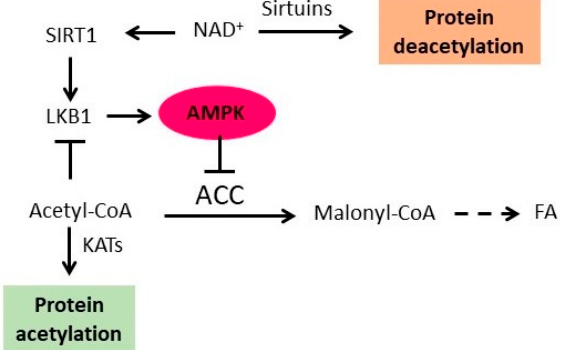
Figure 2. Model of the feedback regulation of AMPK by protein acetylation. AMPK phosphorylates and inhibits ACC, thus increasing acetyl-CoA cellular level and promoting KAT-mediated protein acetylation. Acetylation of liver kinase B1 (LKB1) inhibits the ability of LKB1 to activate AMPK. AMPK also promotes synthesis of NAD + , thus activating SIRT1 and other sirtuins and promoting protein deacetylation. SIRT1 deacetylates and activates LKB1, resulting in AMPK activation. Arrows denote activation, t-bars denote inhibition, and dashed arrow indicates multistep pathway.